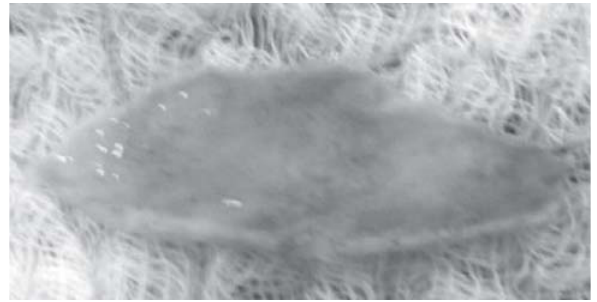
Fig. 2 – Extremidades do enxerto cortadas de forma arredondada, tornando o mesmo ovalado